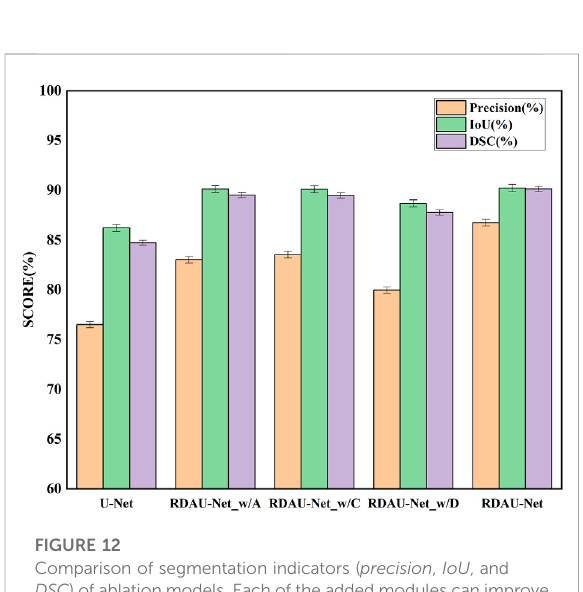
FIGURE 12 Comparison of segmentation indicators ( precision , IoU , and DSC ) of ablation models. Each of the added modules can improve the performance of the